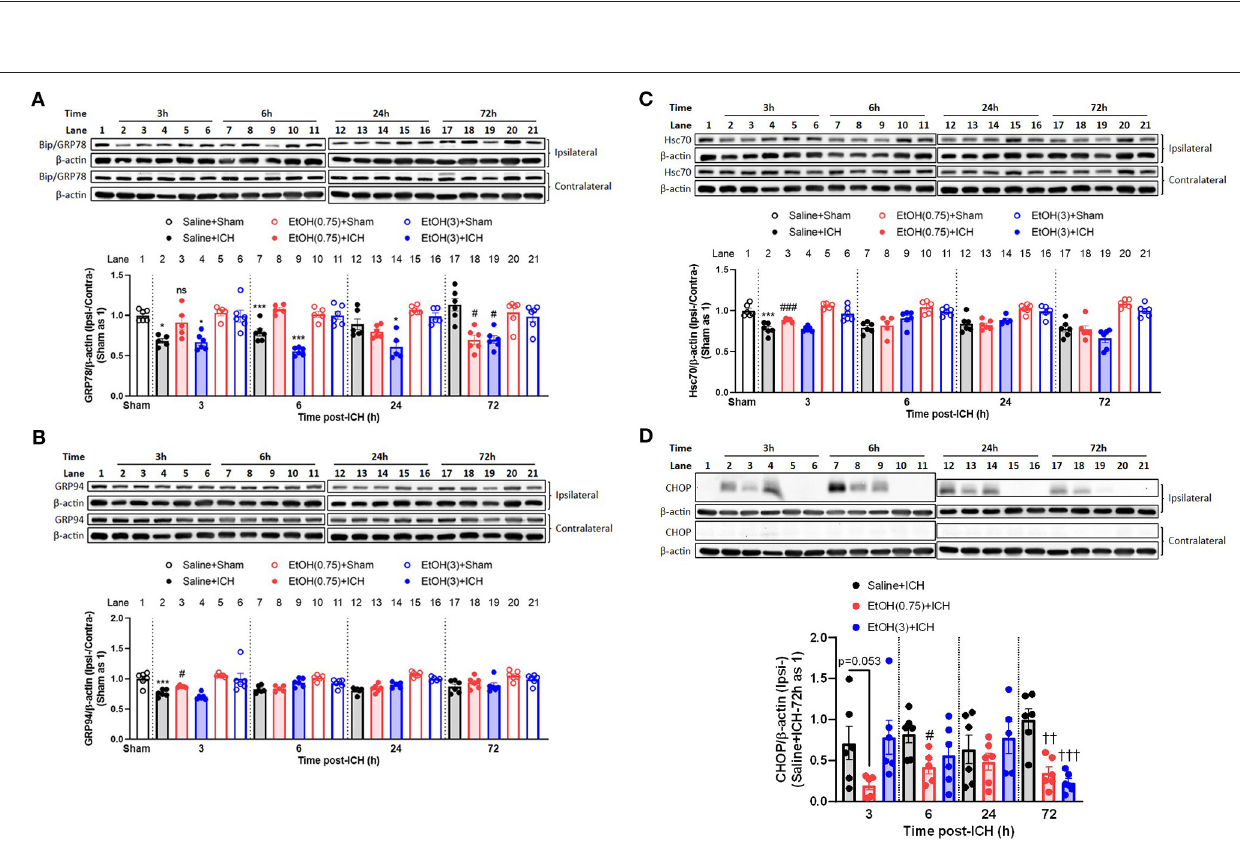
FIGURE 5 | Moderate ethanol pre-conditioning restored the ICH-mediated reduction of chaperone protein and induction of CHOP protein. (A–D) Representative western blotting images showing bands of GRP78 (A) , GRP94 (B) and Hsc70 (C) , and CHOP (D) and quantitative analyses of each target protein detected in the ipsilateral and contralateral striatal lysates from each group and in each time point (3, 6, 24, and 72h post-ICH). Values are shown as means ± SEM ( n = 5–6). * p < 0.05, *** p < 0.001 as compared to normal group. # p < 0.05 as compared to Saline + ICH group. †† p < 0.01 and ††† p < 0.001 as compared to saline + ICH group on 72h